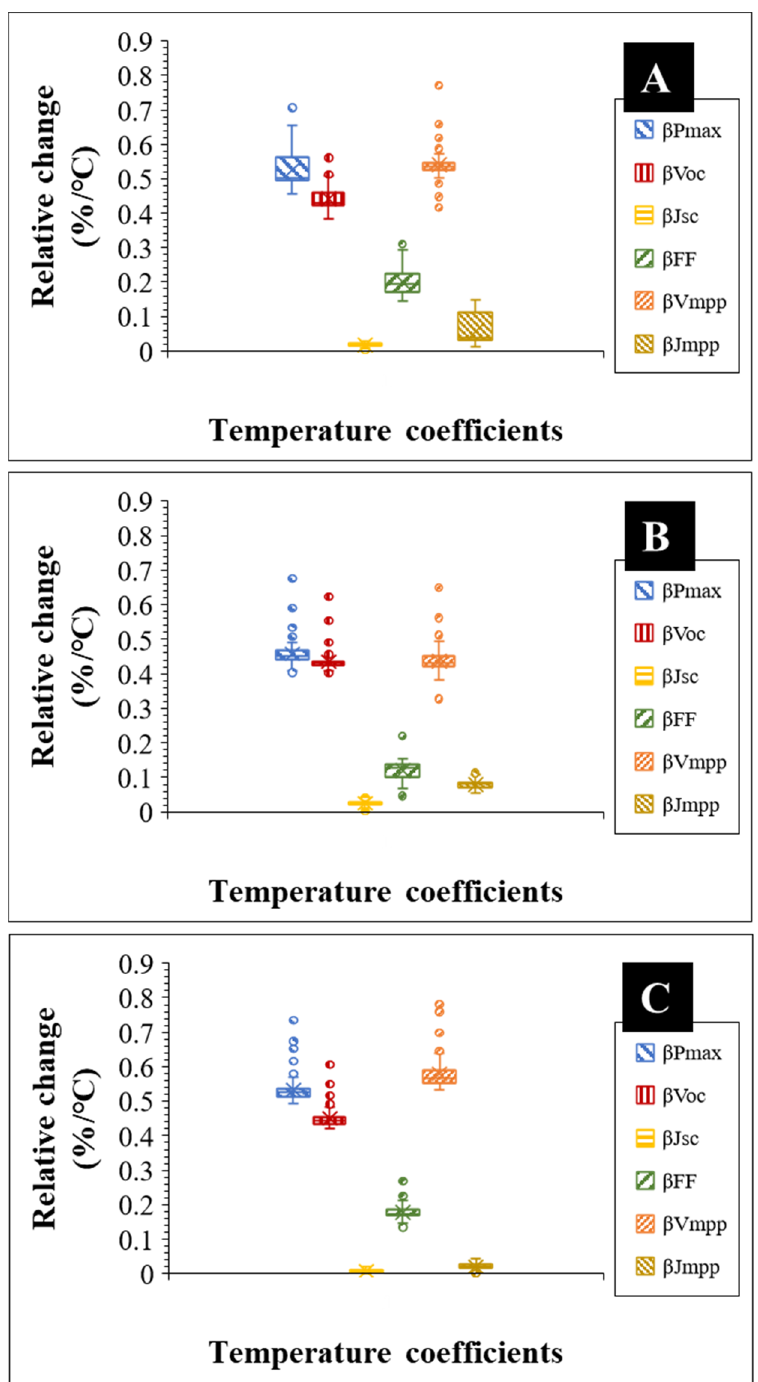
Figure 8. Change in the relative temperature coefficients of the 3 solar panels under STC conditions. The tips of the boxes show the interquartile ranges. The internal lines show the median and the x -marks show the mean. Measurements were done under 960 W/m 2 –1060 W/m 2 in-plane irradiance